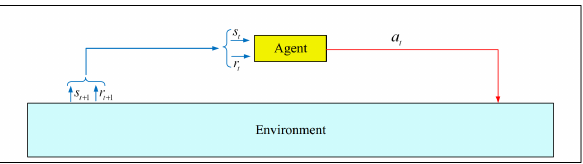
Figure 8. Single-agent learning system.